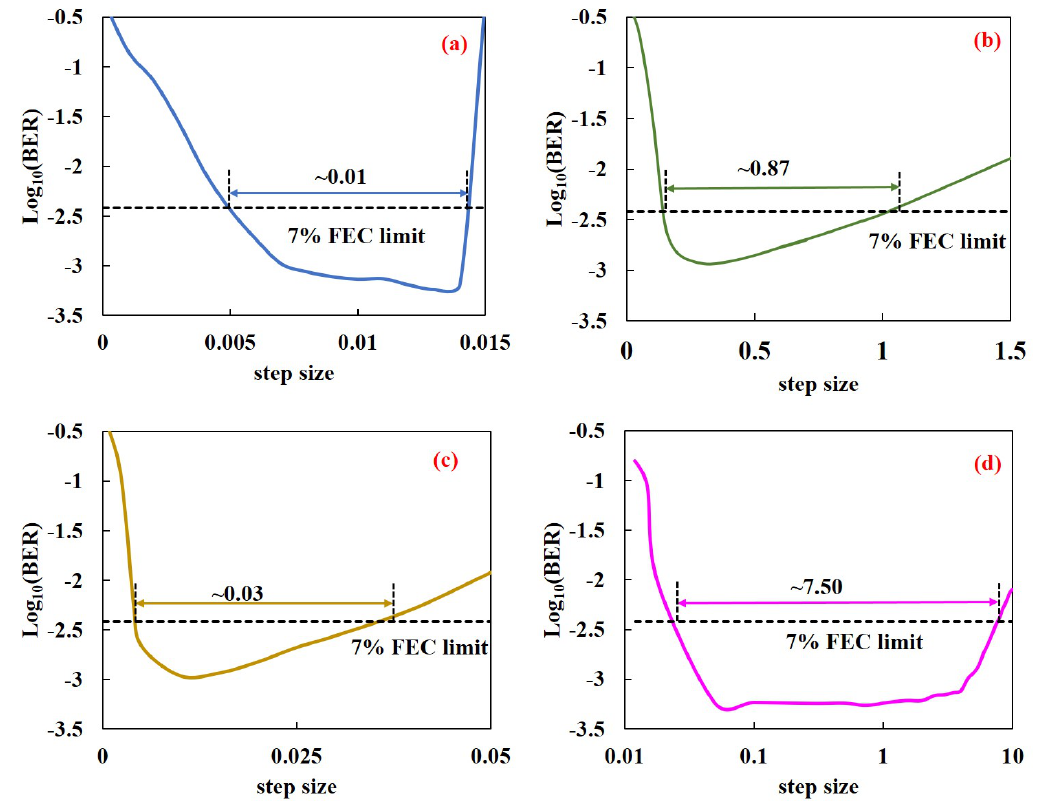
Figure 5. BER versus step size for 129-Gbit/s optical PAM8 system with different optimization ( c ) RMSprop algorithm; and ( d ) Adam algorithm. Table 1. Computational complexity per iteration of optimization algorithms of NNs introduced to tap estimation of traditional equalizer. BGD AdaGrad RMSProp